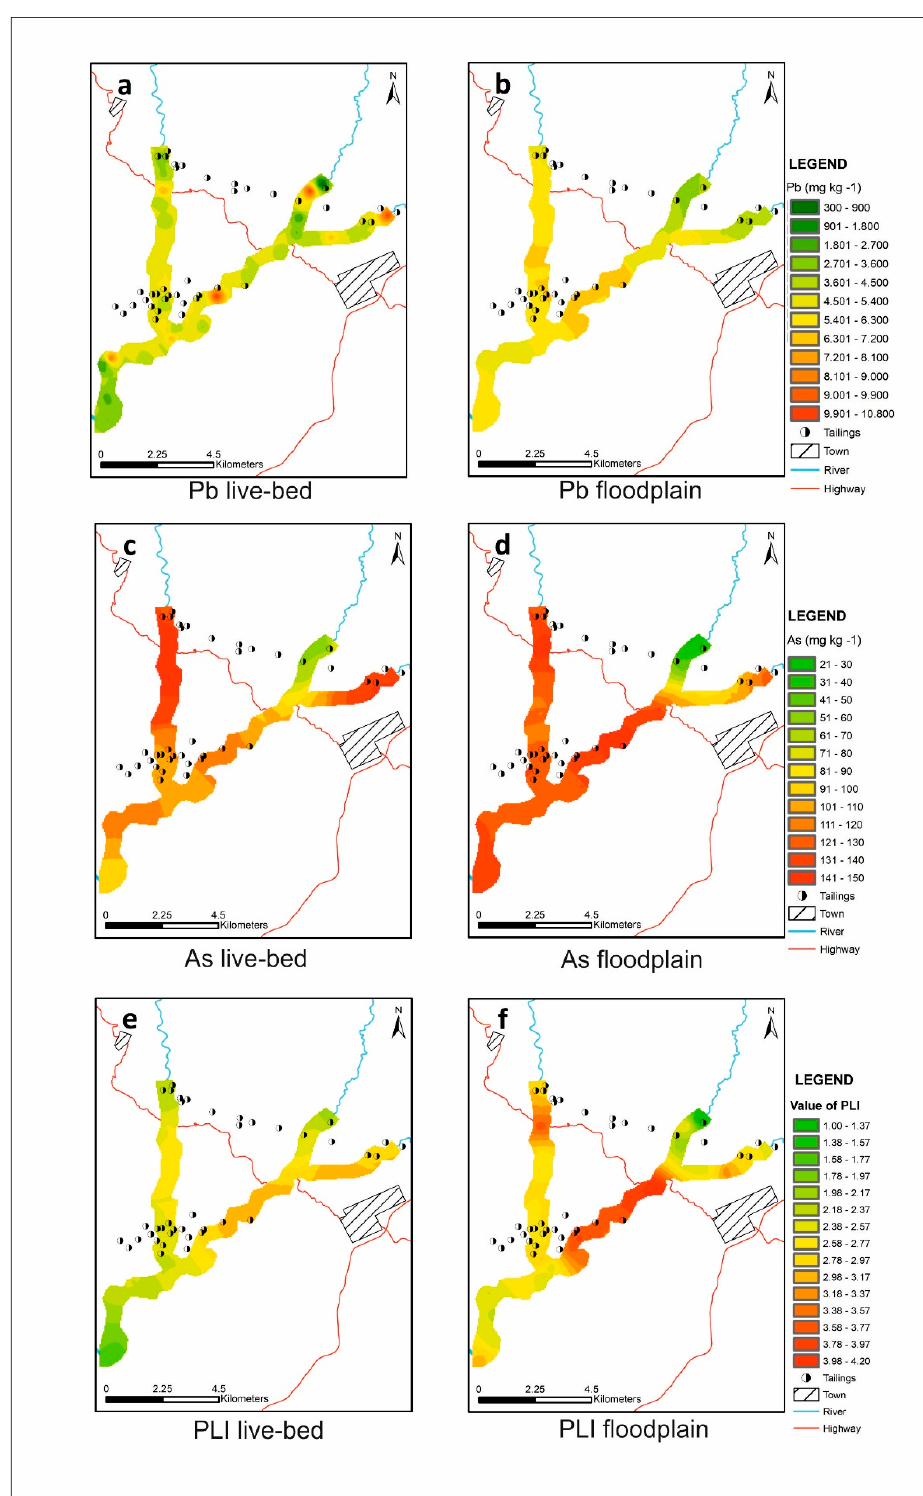
Figure 6. Spatial variation of the Pb and As contents and the pollution load index (PLI) values in the channel and floodplain of the rivers of the La Carolina mining district. ( a )—Spatial variation of the Pb contents in live-bed; ( b )—Spatial variation of the Pb contents in floodplain. ( c ) Spatial variation of the As contents in live-bed; ( d )—Spatial variation of the As contents in floodplain. ( e )—Pollution load index (PLI) values in live-bed; ( f )—Pollution load index (PLI) values in floodplain.